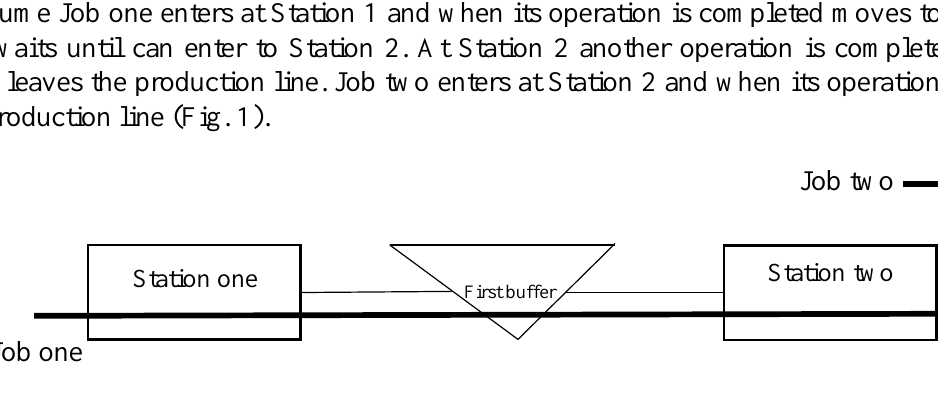
Fig. 1. A job shop production